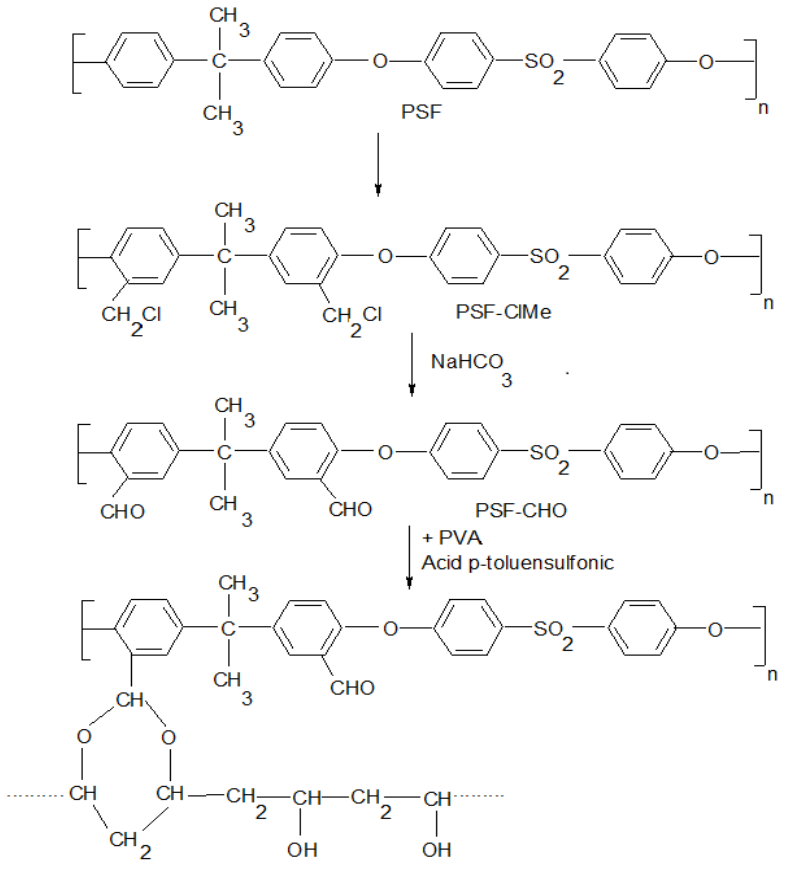
Scheme 1. Schematic representation of synthetic pathways for preparation of mPSF polymer.